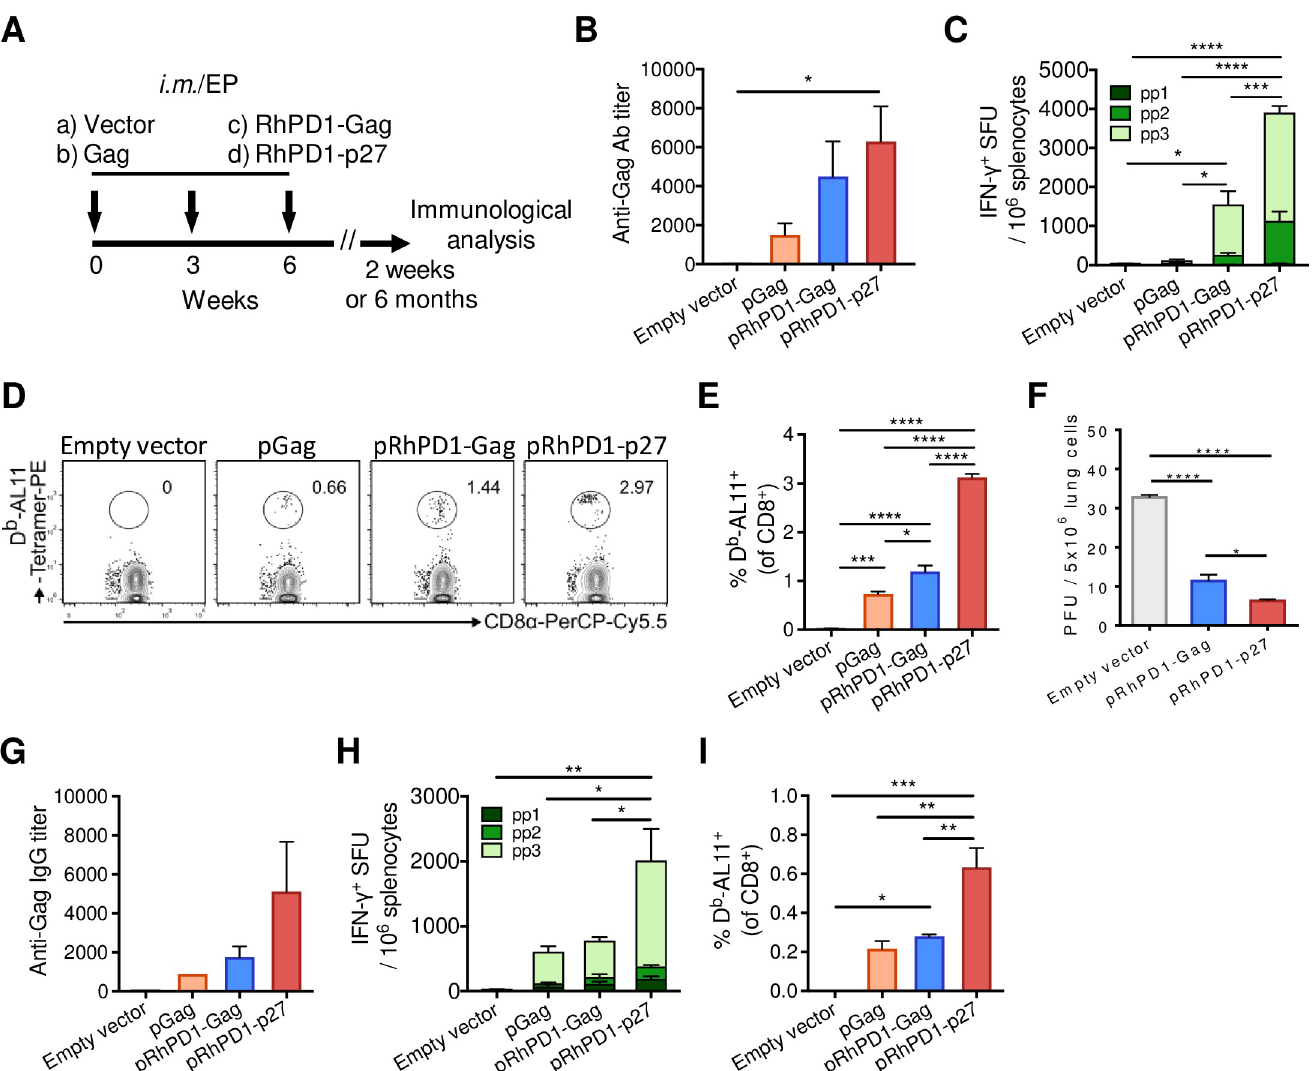
Fig 1. Immunogenicity of RhPD1-based vaccines in mice. ( A ) Schematic of DNA vaccination in mice. C57BL/6 mice were immunized with the empty pVAX vector, pGag, pRhPD1-Gag or pRhPD1-p27 via intramuscular injection with 3 consecutive electroporation in 3-week intervals. Immunological analysis was performed at 2 weeks or 6 months after the last immunization. ( B)—(E ) Acute humoral and cellular immunity induced by sPD1-based vaccines 2 weeks post-last immunization. ( B ) Anti-Gag antibody titers in sera. ( C ) Gag-specific cellular immune responses in spleens evaluated by IFN- γ ELISpot assays. ( D ) Representative FACS plots showing the presence of H-2D b /AL11-specific CD8 + T cells in the spleens of vaccinated mice by tetramer staining analysis. ( E ) Frequencies of H-2D b / AL11-specific CD8 + T cells in vaccinated mice. ( F ) The efficacy of the sPD1-based vaccines against recombinant vaccinia virus challenge. Two weeks after last immunization, mice were challenged with recombinant vaccinia virus MVTT-SIV gpe via intranasal route. Viral loads in the lungs were determined two days after challenge. ( G)—(I) Memory humoral and cellular immune responses elicited by the sPD1-based vaccines at 6 months post last immunization. (G) Anti-Gag IgG titers in sera. (H) Gag-specific IFN- γ ELISpot responses and (I) the frequencies of H-2D b /AL11-specific CD8 + T cells in spleens.